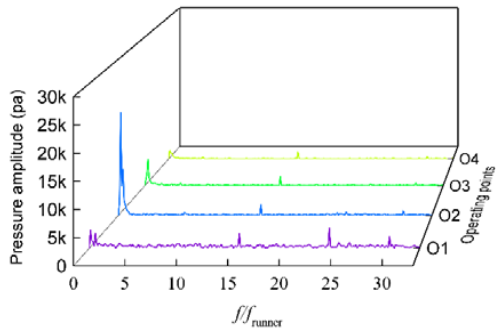
Figure 10. Spectral analysis of the pressure signals of D 1 in the draft tube under the four different operating conditions.